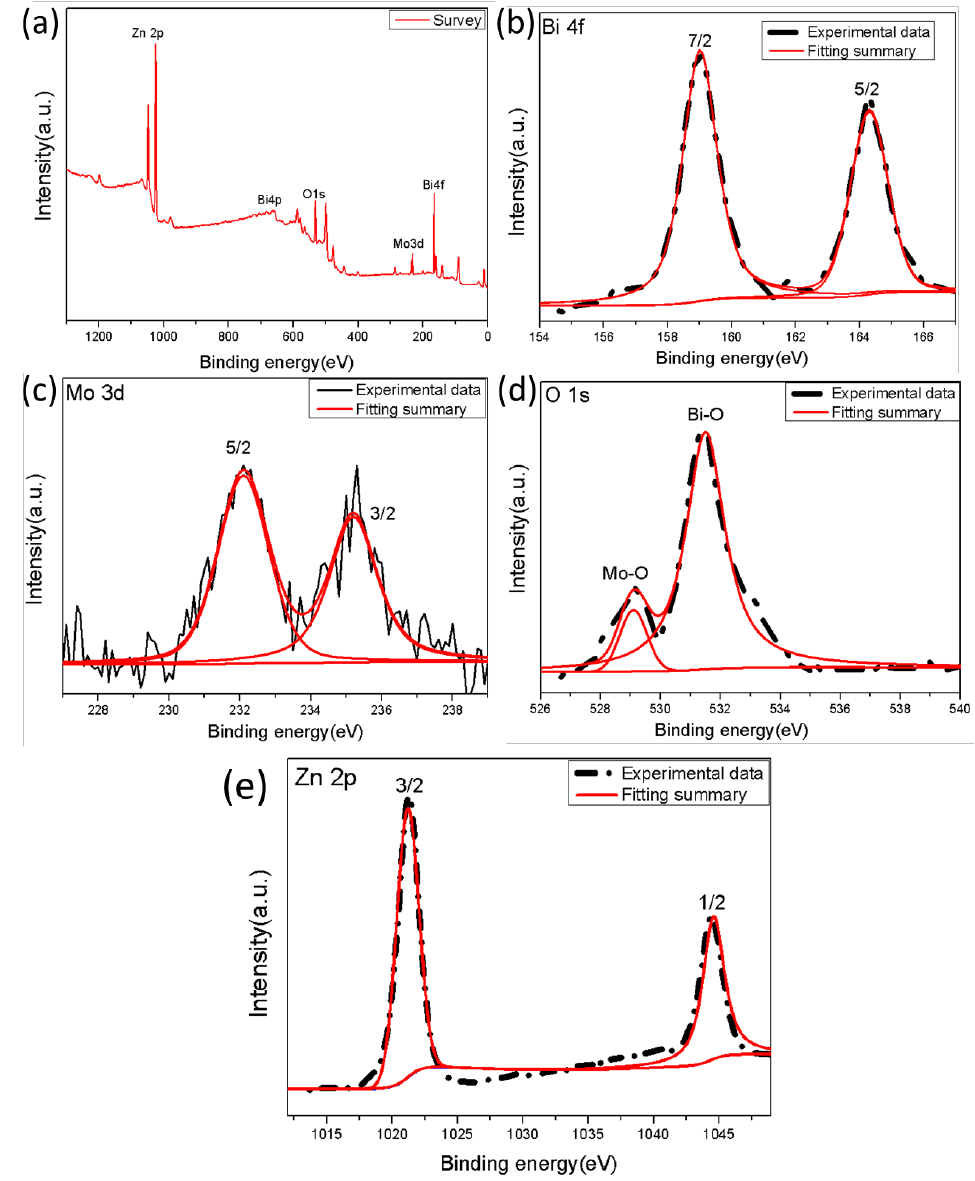
Figure 8. XPS spectra of 0.4-BZO catalyst ( a ) Survey and core level spectra ( b ) Bi 4f, ( c ) Mo 3d, ( d ) O 1s, and ( e ) Zn 2p. ( d ) O 1s, and ( e ) Zn